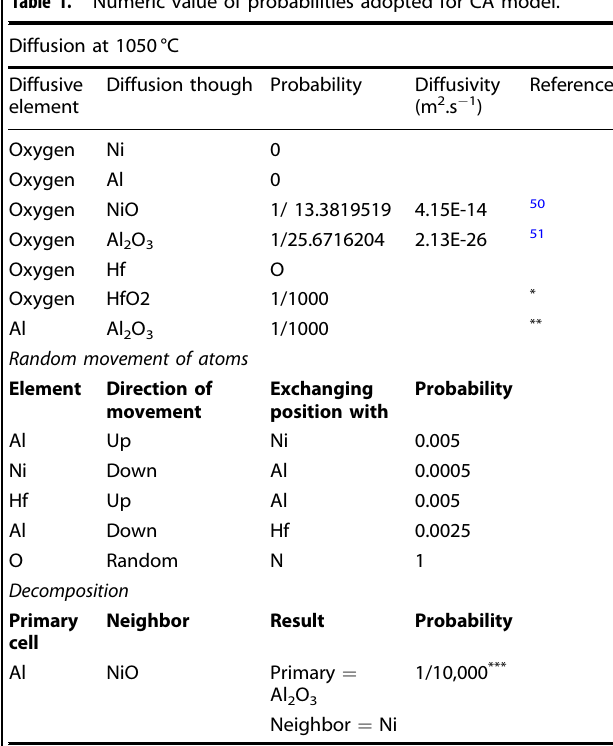
Table 1. Numeric value of probabilities adopted for CA